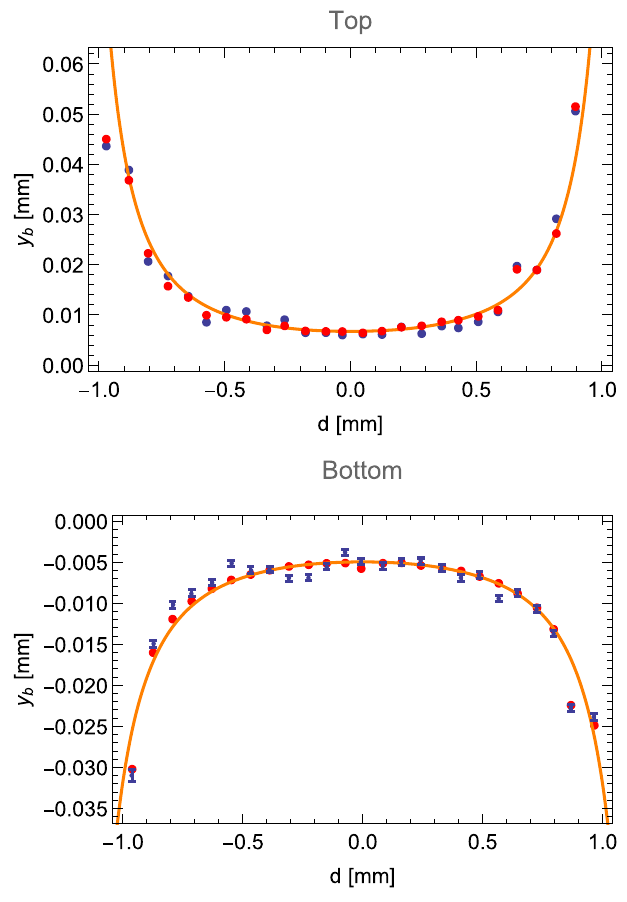
FIG. 8. Measurement of downstream beam offset, y , vs. jaw b tilt parameter, d , for the Top (top plot) and Bottom (bottom plot) dechirper jaws. The blue plotting symbols give the measurement points, after they have been shifted vertically by − y , horizon- b 0 tally by − d 0 , of the fitted parameters. The red curve gives the theoretical value assuming b is fixed at b ¼ h b i ¼ 1 . 14 (1.26) mm for the Top (Bottom) case. The red symbols give the more accurate theoretical result, obtained from the two-parameter fit to the measured ( δ b , d i